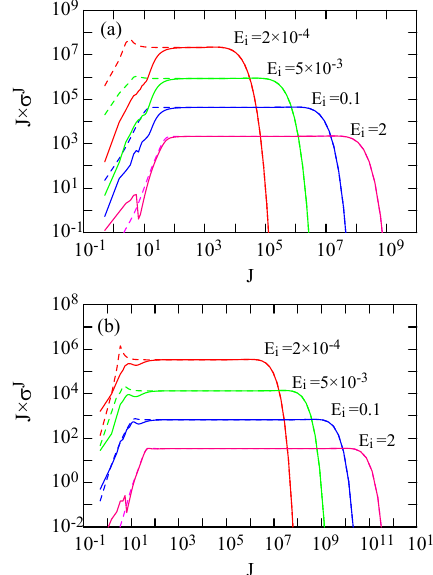
Figure 5. Variation of J × σ J with partial waves J for ( a ) 5d 5/2 –5f 7/2 and ( b ) 5g 7/2 –5f 7/2 transitions. Broken curves: Born and continuous curves: CC+Born results. Energies are in Ryd.